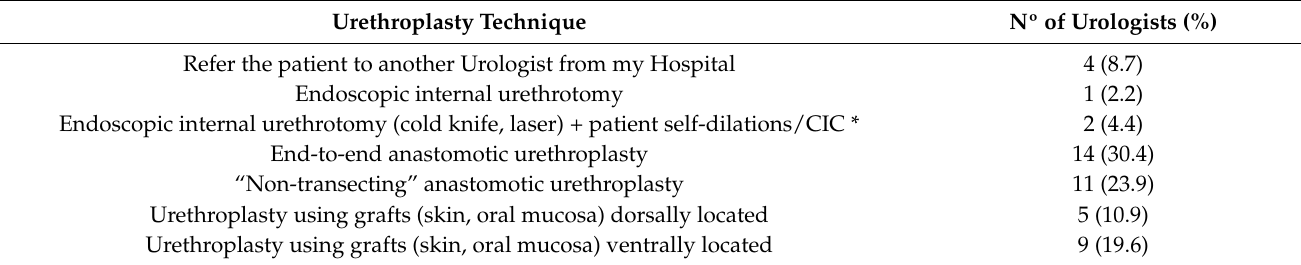
Table 8. How would you manage in your clinical practice a 24 year-old male, with a 1 cm idiopathic proximal bulbar urethral stricture, with 2 previous internal urethrotomies (last one 6 months ago), complaining of poor flow and with maximum flow rate of 6